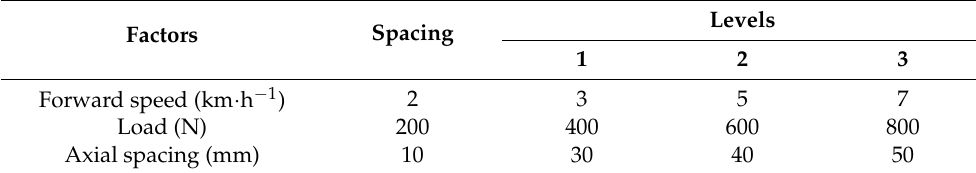
Table 1. Factor coding and experimental levels.